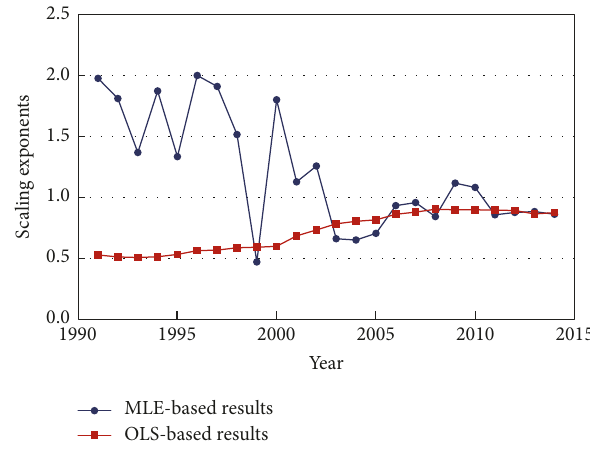
Figure 8: A comparison between the change trend of MLE-based allometric parameter values and that of OLS-based parameter